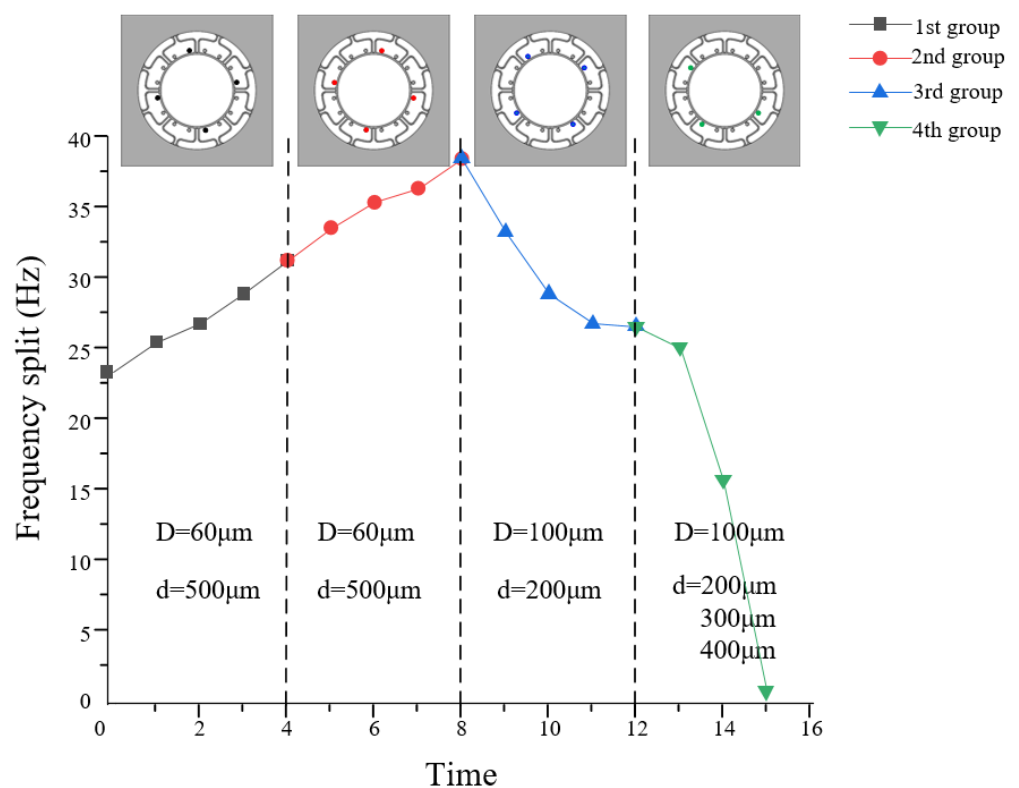
Figure 11. The correlation curves between frequency split and removed mass in four sets of experi- ments.